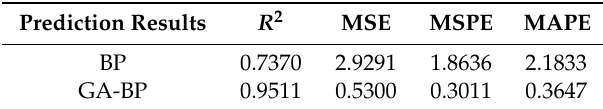
Table 3. Prediction performance of the BP and GA-BP models tested by the six remaining random samples.